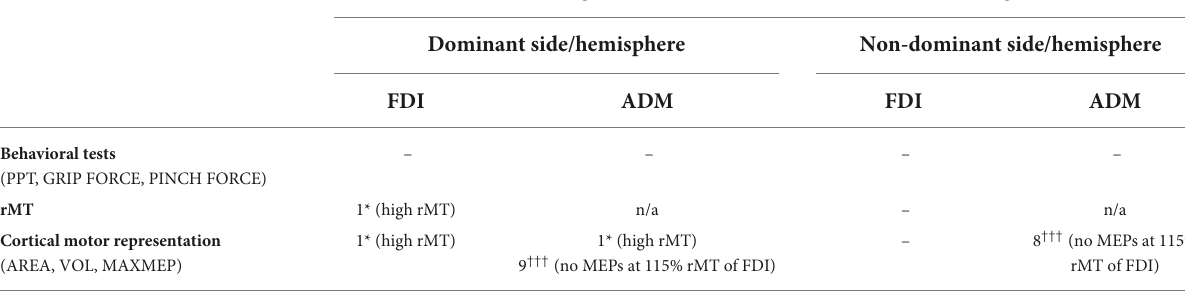
TABLE 2 Overview of missing outcomes within the total sample of 73 participants and justification.